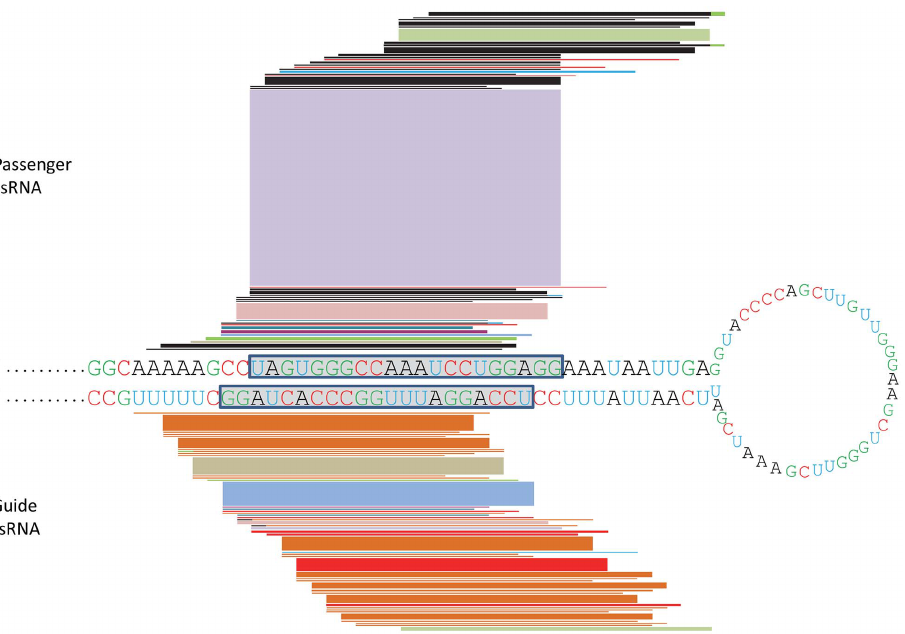
Figure 3. Distribution of the 16D10 small RNAs along the pART27-42 hairpin stem. The hairpin structure of the pART27-42 construct (the spliced-out intron not included) is presented with the 16D10 passenger ssRNAs aligned along the sense strand (above) and the guide ssRNAs aligned along the antisense strand (below). The relative small RNA abundance is graphically represented by the relative thickness of a block/line. Due to the limitation of graphic resolution, only those small RNAs with more than 200 reads were presented. The blocks with color variation in the 3 9 ends indicate presence of mismatches. The ‘‘.’’ at the stem base represents the 5 9 and 3 9 overhangs due to the presence of cloning sites and other residual sequences from the pART27-42 construct. The green arrows pointed to the first putative dicer cleavage site (21 nts away from the 5 9 residue) and the red arrows pointed to the second putative dicer cleavage site (21 nts away from the first putative cleavage site). The grey boxes highlighted the siRNA duplex produced by these two cleavage events. Data for this figure were provided in Table 2 and Table S2.